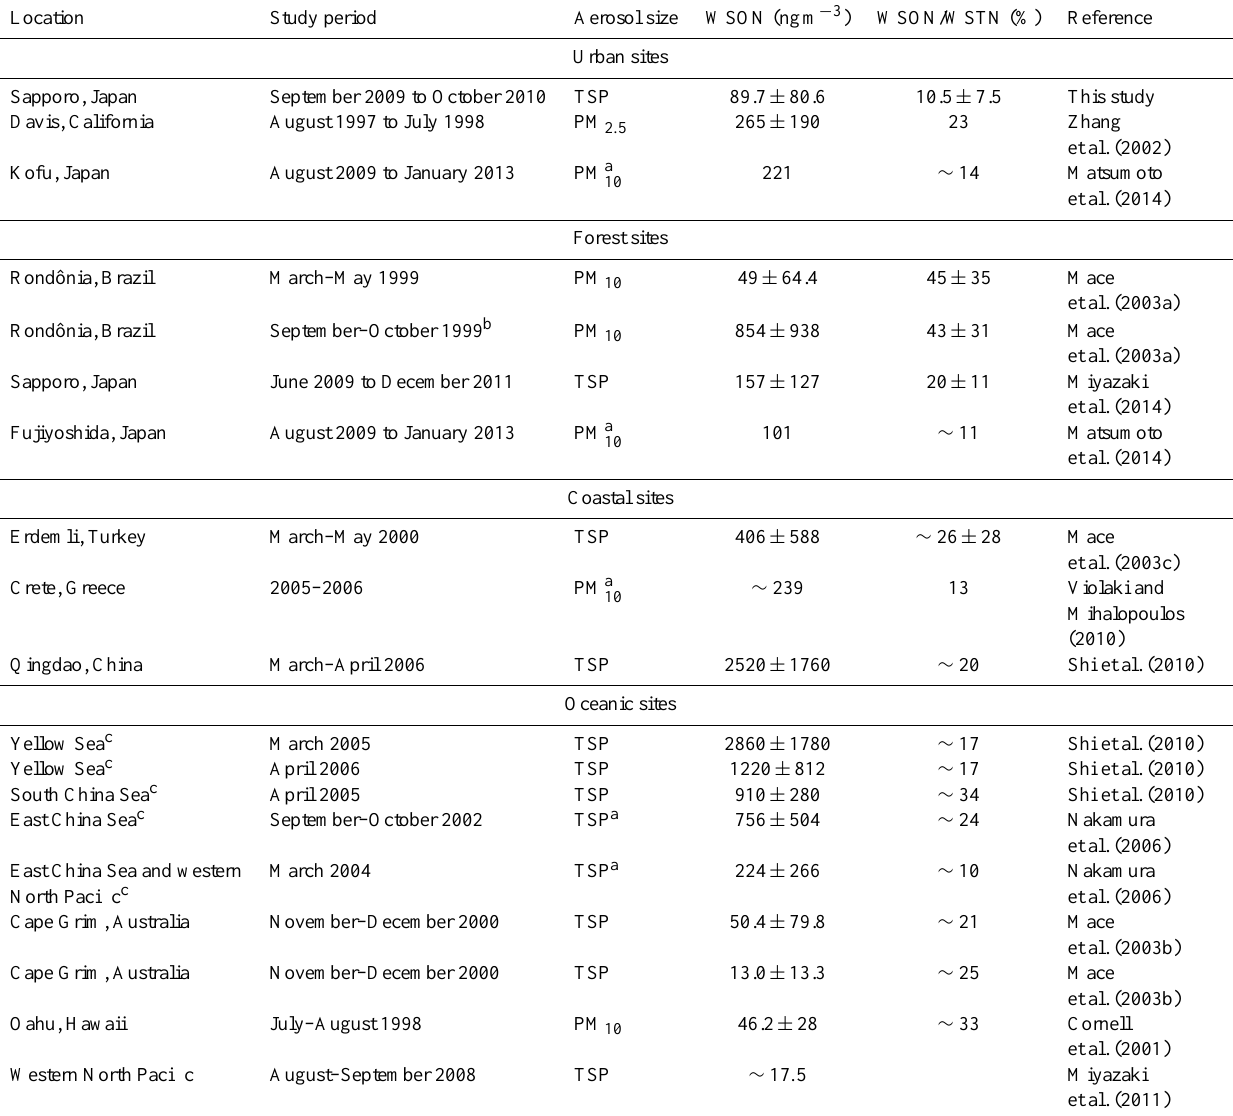
Table 2. Concentrations of water-soluble organic nitrogen (WSON) and the mass fractions of WSON in water-soluble total nitrogen (WSTN) in Sapporo aerosols together with those in atmospheric aerosols from different sites around the